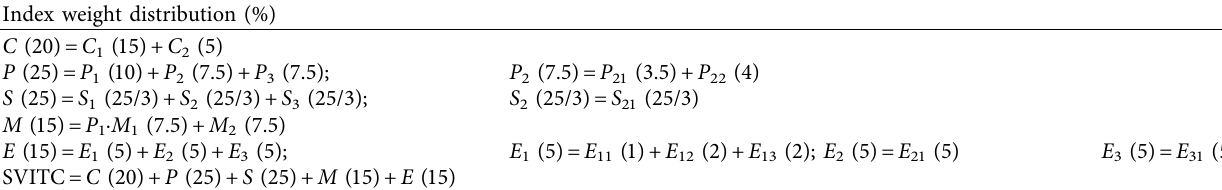
Table 3: Subjective weights’